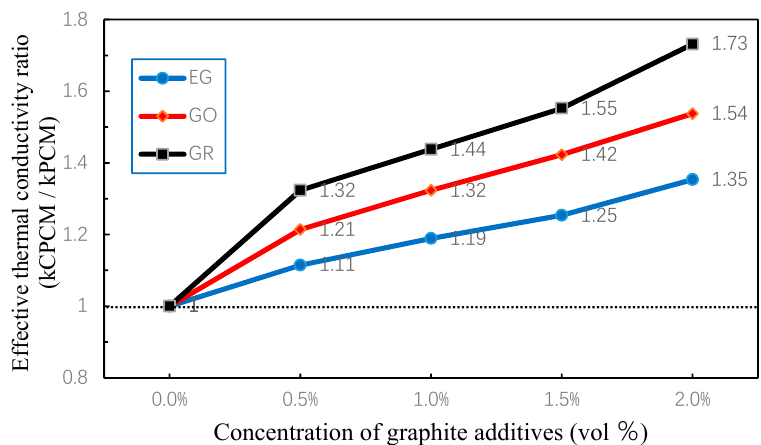
Figure 9. Effective thermal conductivity ratio as a function of the concentration of graphite additives.